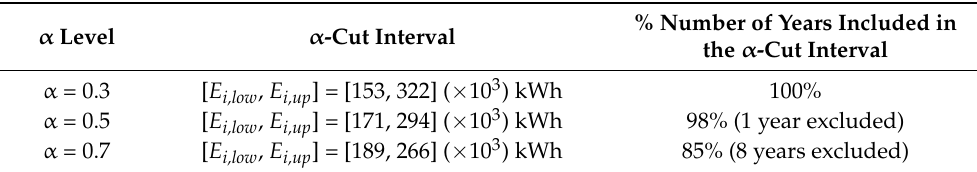
Table 4. Interval results and verification with different α -cut